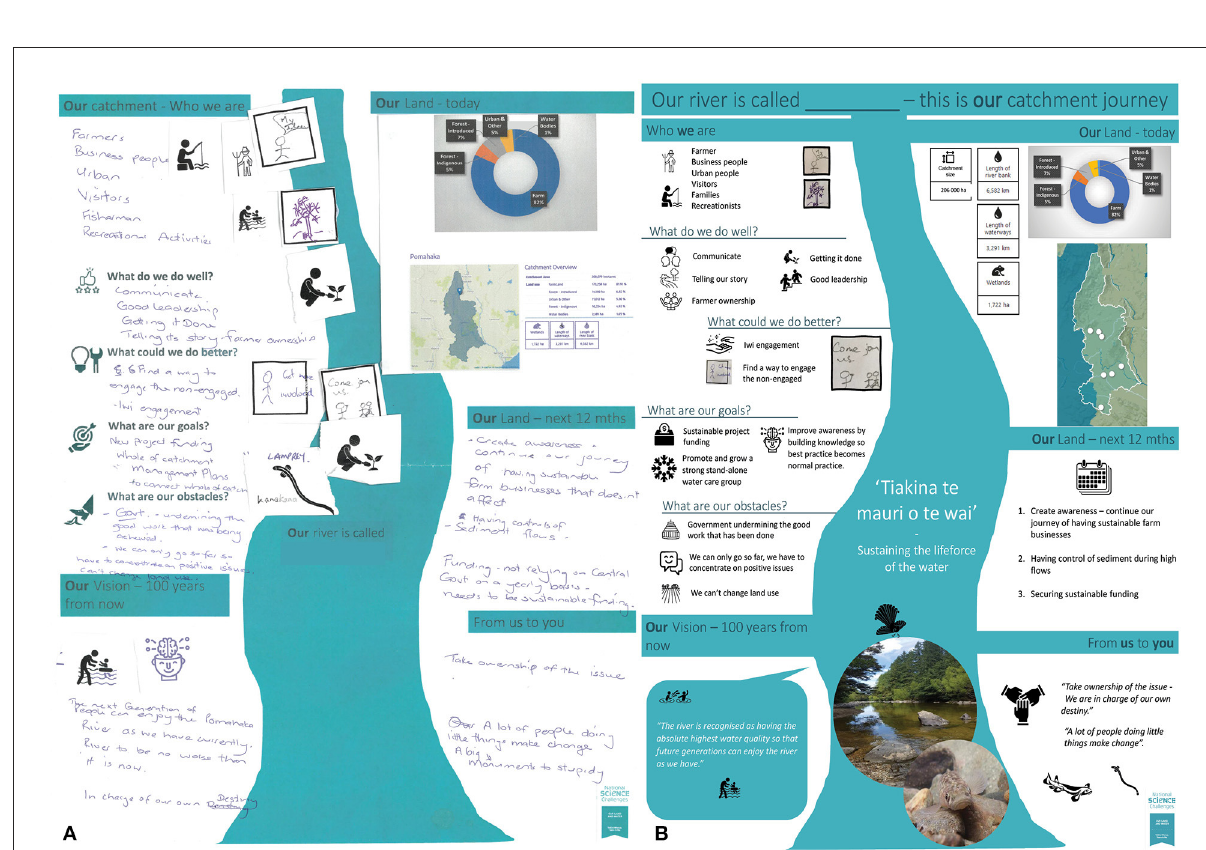
FIGURE1 Examples of (A) a template filled in by a focus group, and (B) a digitized Catchment